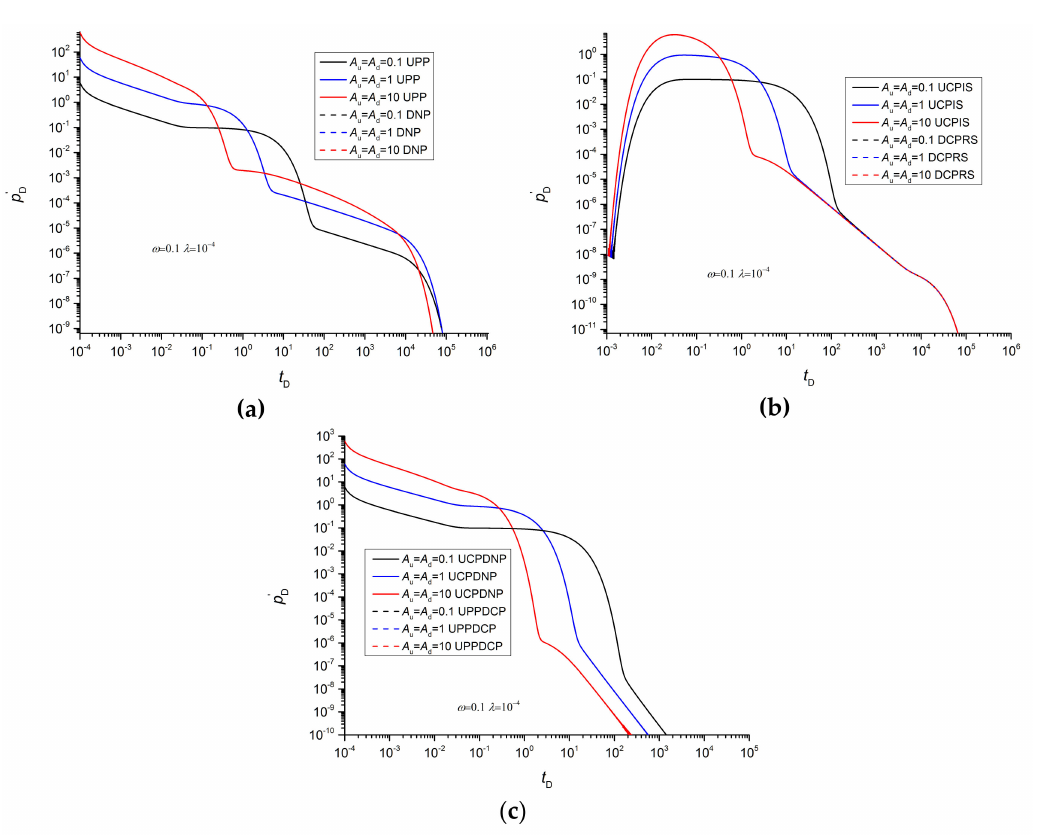
Figure 6. Coincident pressure derivative curves of di ff erent methods: ( a ) UPP vs. DNP; ( b ) UCPIS vs. DCPRS; ( c ) UCPDNP vs.